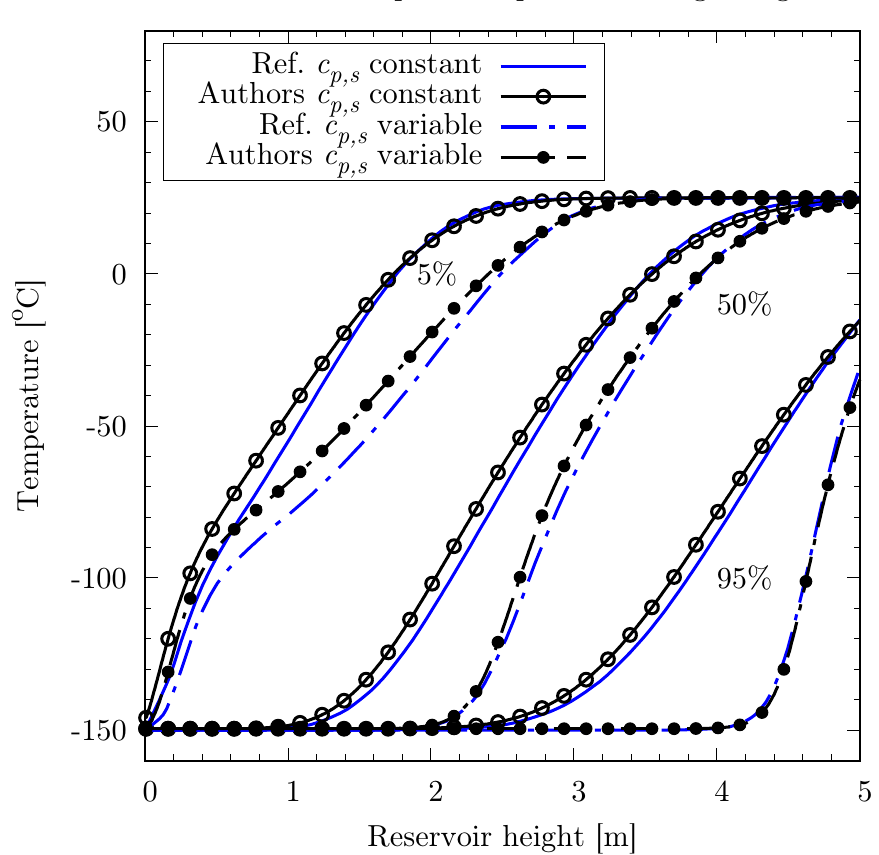
Figure 1. Temperature distribution inside the cold reservoir during the charging process, at different charging stages (5%, 50% and 95%). Our are compared with the results reported in [31,37]. In black empty dots, temperature profiles are reported considering constant the storage material’s specific heat (the mean value is selected). In black filled dots, temperature profiles concern the case of a variable storage material’s specific heat: each layer has a different value for this parameter, according to the actual